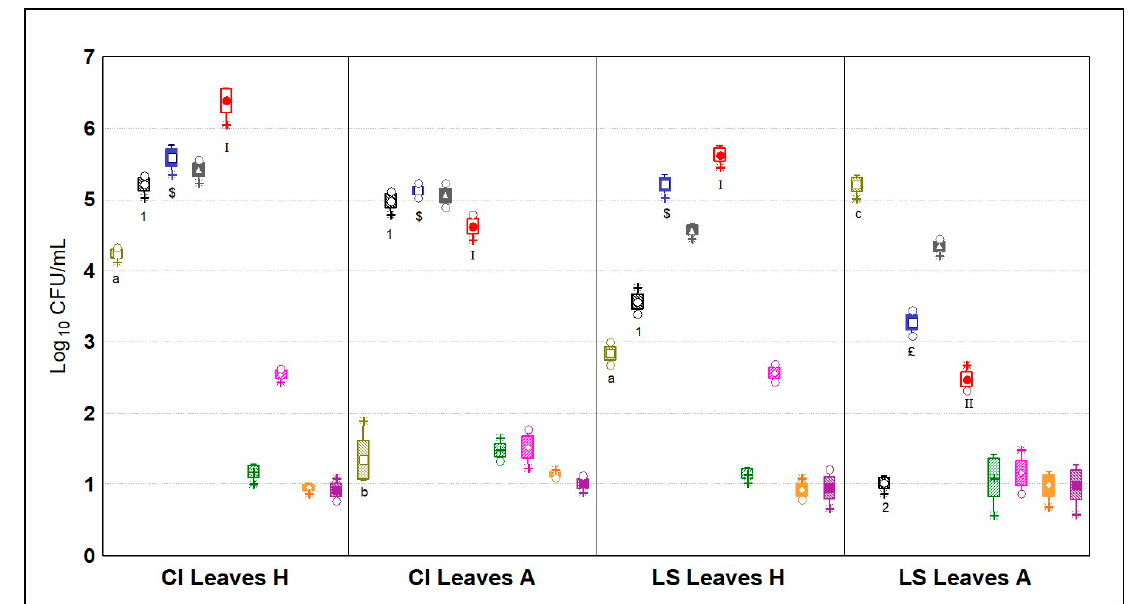
Figure 5. Microbial quantities in Log 10 CFU/mL ( n = 4) of the nine different microbial targets; olive green = coliforms; black stripes = Enterobacteriaceae ; blue = aerobic mesophilic bacteria; gray = anaerobic mesophilic bacteria; red = psychrotrophic bacteria; green = lactic acid bacteria; fuchsia = yeasts and molds; orange = Pseudomonas spp.; violet = enterococci; CI = Chicorium intybus ; H = hydroponic cultivation; A = aquaponic cultivation; LS = Lactuca sativa . Different letters, numbers, Latin numbers, or symbols indicate statistical significance among a microbial target by Tukey’s HSD test ( p < 0.05). Samples were analyzed in duplicate from two independent experiments ( n = 4). Box = mean; rectangles = mean*S.D.; whiskers = min and max values; asterisks = extremes; dots =